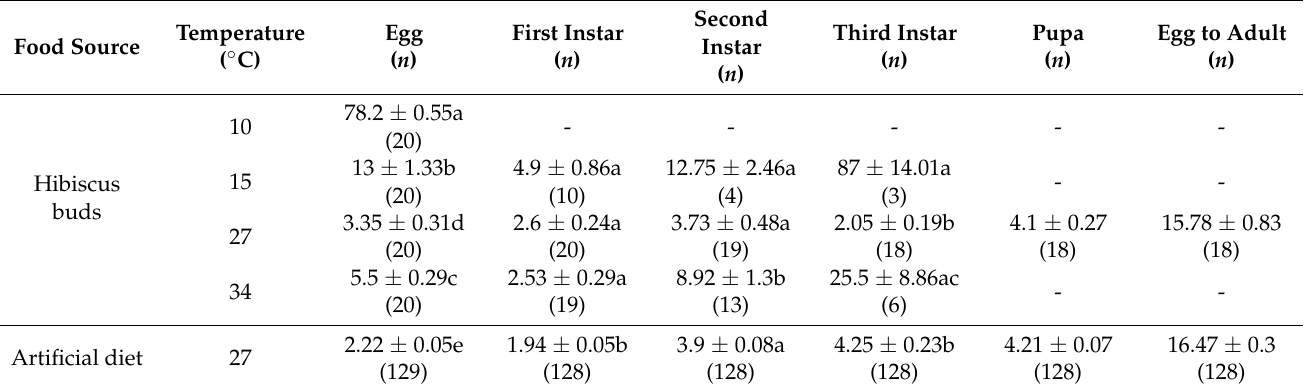
Figure 2. Correlation of larval head capsule widths and lengths of the hibiscus bud weevil ( Anthono- mus testaceosquamosus ). The three different groups correspond to the three larval instars. At 10, 15 and 34 ◦ C, the HBW was not able to complete its life cycle (Table 2). Temper- ature significantly affected the development of the egg (LM: F = 5850.94, df = 3, p << 0.001), second (LM: F = 28.97, df = 2, p << 0.001) and third instar stages (LM: F = 9.72, df = 2, p << 0.001). Eggs failed to hatch at 10 ◦ C while development through the third instar was observed at 34 ◦ C. At 27 ◦ C, eggs hatched within 3.35 ± 0.3 days ( ± SE) on average while the entire life cycle (egg-adult) was completed in 15.78 ± 0.8 days ( ± SE) on average (Table 2). Table 2. Mean developmental time (days) ± SE of the hibiscus bud weevil ( Anthonomus testaceosquamo- sus ) under different temperatures and food sources at 60% RH and 12:12 h L:D. Within each column, different letters indicate significant differences (Tukey, p < 0.05).